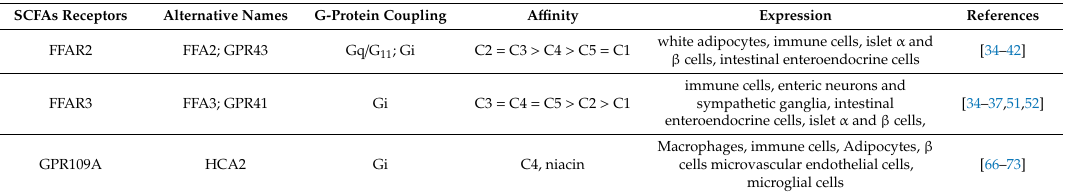
Table 1. Short-chain fatty acids (SCFAs) receptor and its main expression